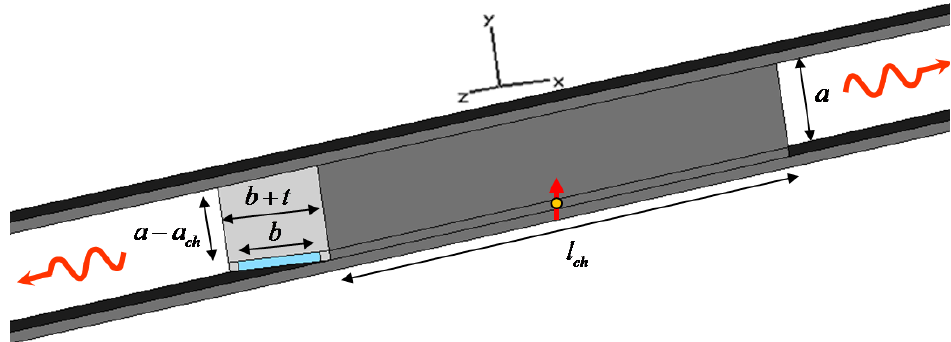
Figure 1. Geometry of interest: a small optical emitter is placed inside a rectangular plasmonic channel connected to a higher MIM waveguide, consistent with the geometry discussed in